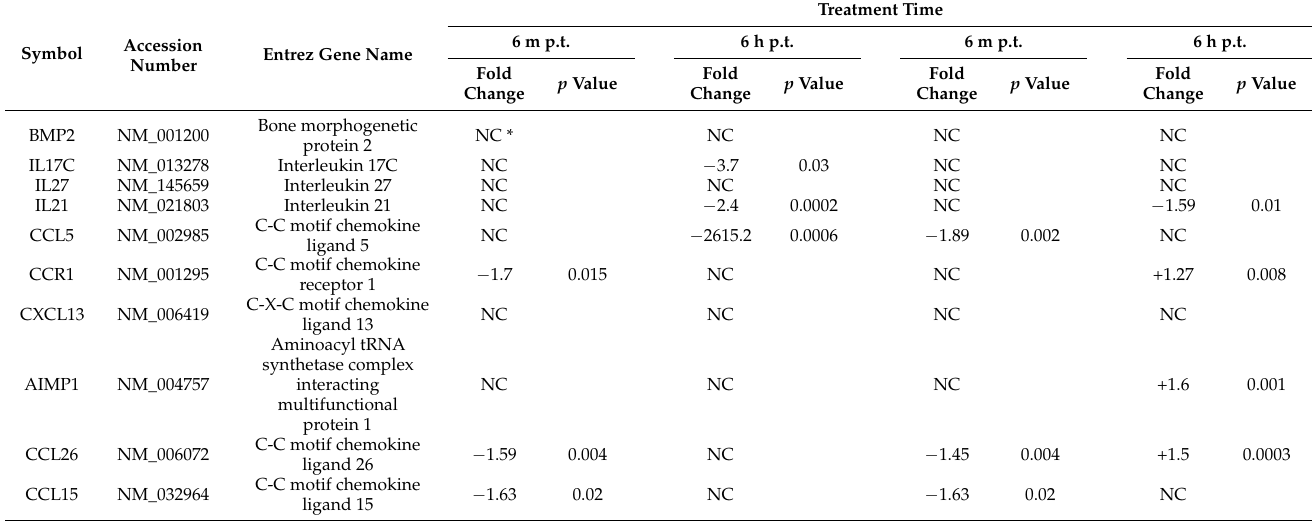
Table 4. Determination of the selected inflammatory genes confirmed the up/downregulated expres- sion in herb-treated DENV-2 TL-30 infected T98G cells compared to untreated viral-infected